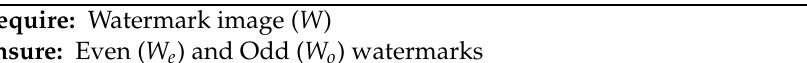
Algorithm 1: Algorithm for watermark